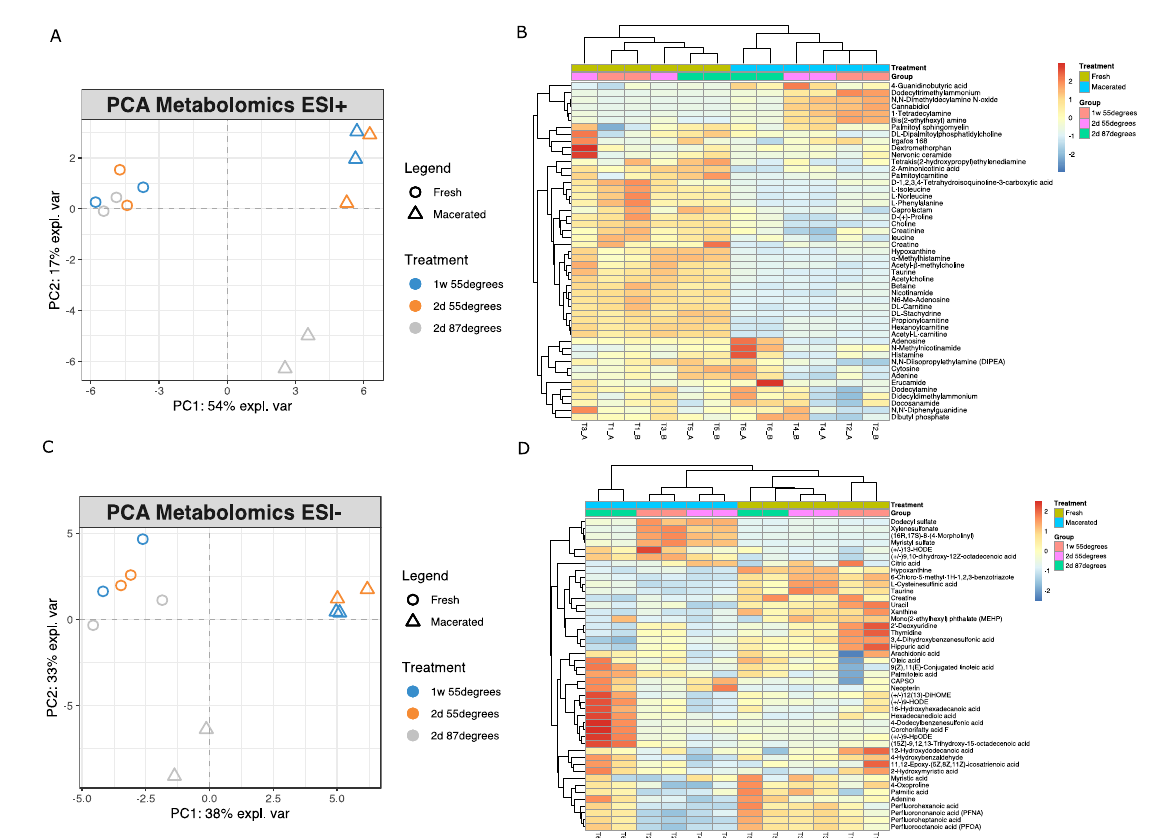
Figure 2. PCA results from metabolites profiled in ESI+ ( A ) and ESI − ( C ) show very similar patterns with clear separations between fresh and macerated bones as well as between protocols involving different temperatures and cleaning agents. Hierarchical clustering ( B , D ) confirms the class separation observed with PCAs.